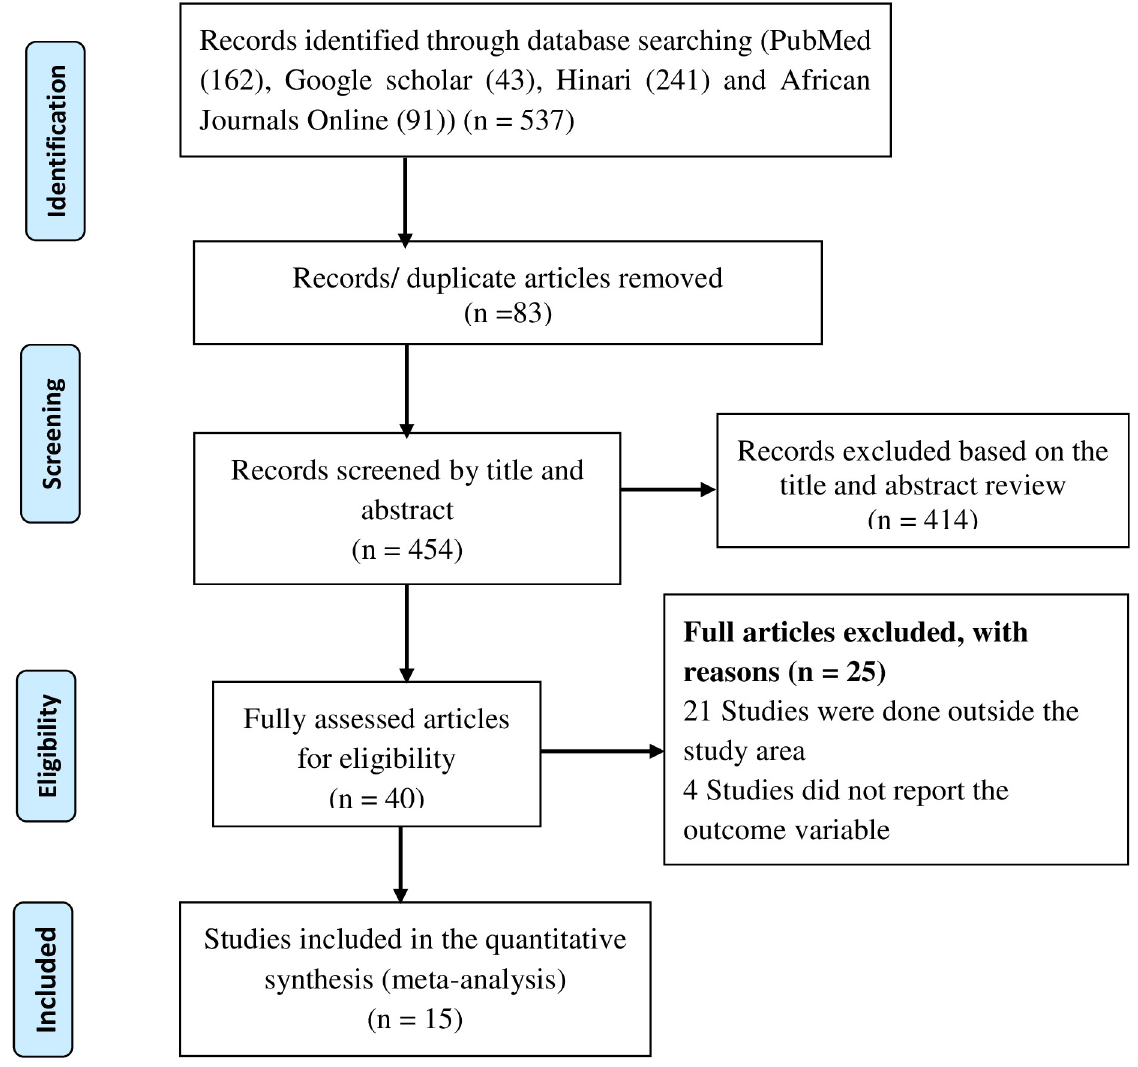
Fig 1. Flow diagram showing the included studies for the systematic review and meta-analysis of maternal lipid profile and pre-